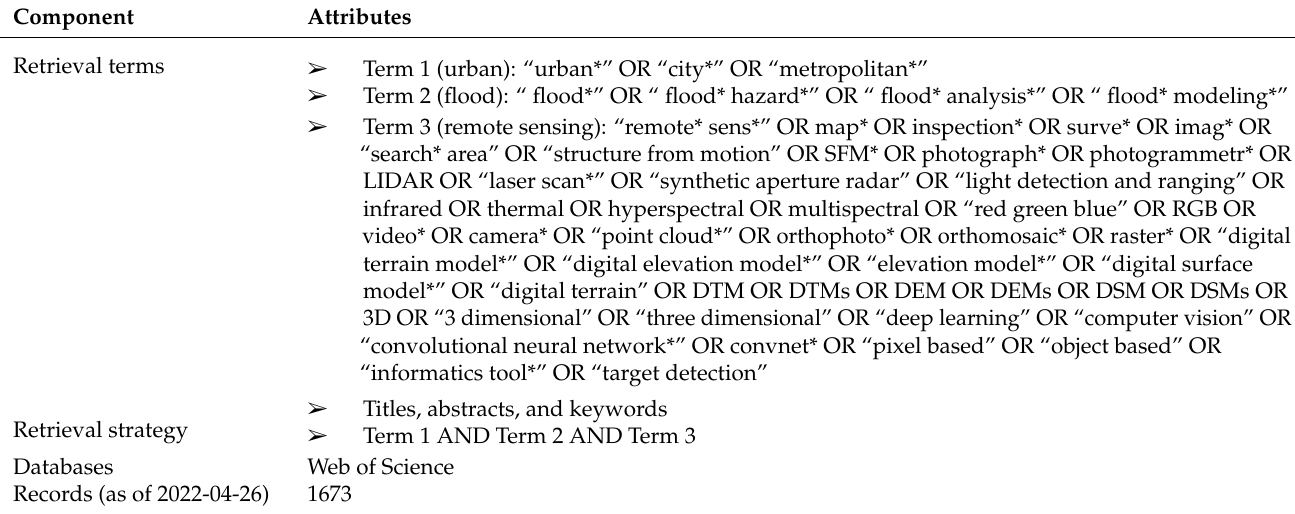
Table 1. Retrieval terms, strategy, databases, and